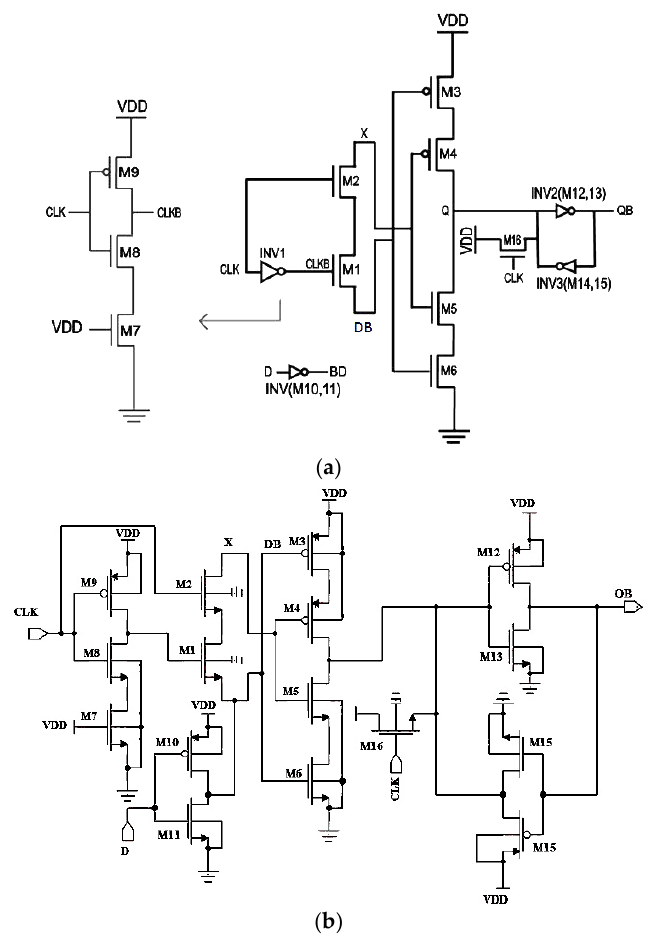
Figure 5. ( a ) Schematic of the proposed flip ‐ flop design; and ( b ) CMOS circuit of the proposed flip ‐